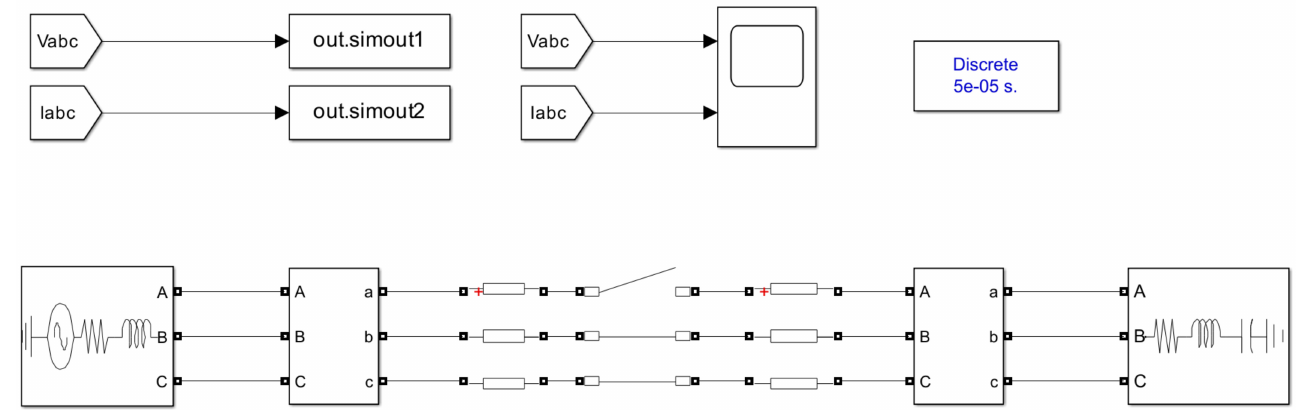
Figure 6. MATLAB open conductor fault simulation.